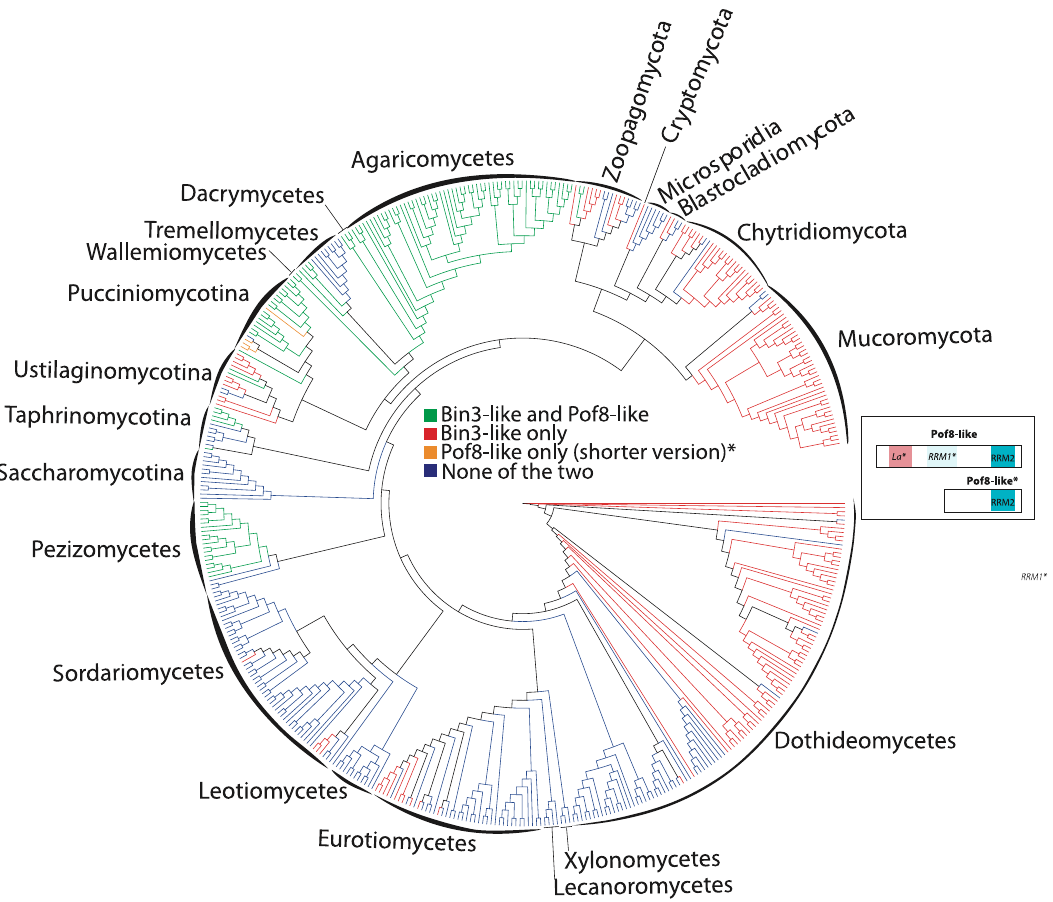
Fig. 6 Phylogenic distribution of Bmc1/Bin3 and Pof8 in fungi. Consensus cladogram describing the phylogenic relationships of 472 species representative of fungi phylum and classes and highlighting (using a color code) the distribution of Bin3 and Pof8 in these species. The cladogram is a consensus tree of 5328 distinct protein coding gene trees resulting from a genome-wide, against all, protein comparison (see “ Methods ” ). Only posterior probabilities inferior to 1 are shown. The Bin3 and Pof8 distribution is recapitulated in Supplemental Data 3 with corresponding protein sequences. A cartoon presenting structural domains of Pof8 is presented. Pof8 La module and RRM1 are only inferred from secondary structure predictions and are represented by La* and RRM1* in the corresponding cartoon. In four species (colored in orange in the cladogram), only an N-terminal truncated version of Pof8 (Pof8*) that cannot accommodate the La module is present. Full cladogram with species names and statistical supports of the different nodes is presented in Supplementary Fig.